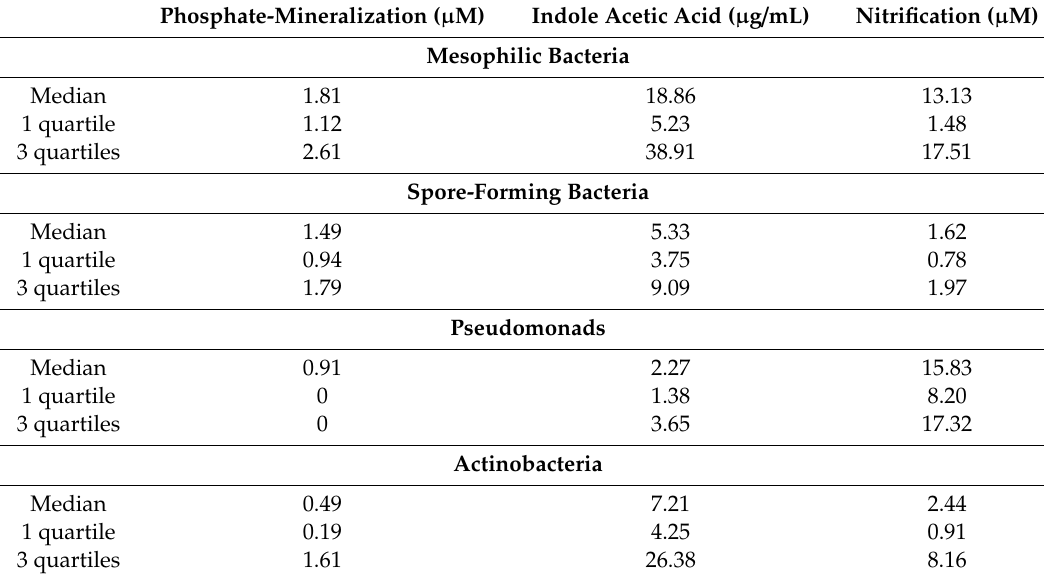
Table 4. Quantitative assays: median and